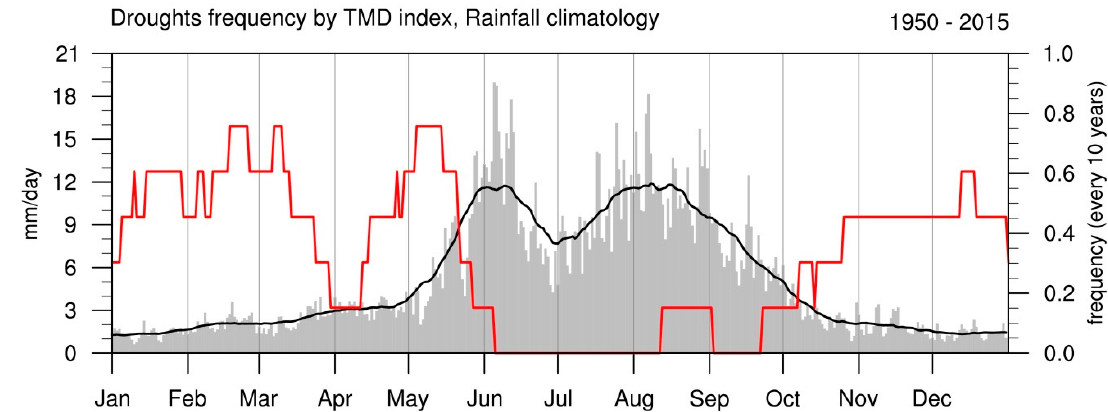
Figure 4. The frequency of severe droughts identified by the TMD index (red line), and daily rainfall climatology values in Taiwan from 1950 to 2015 (gray bars) with their 31-day running mean values (black line).